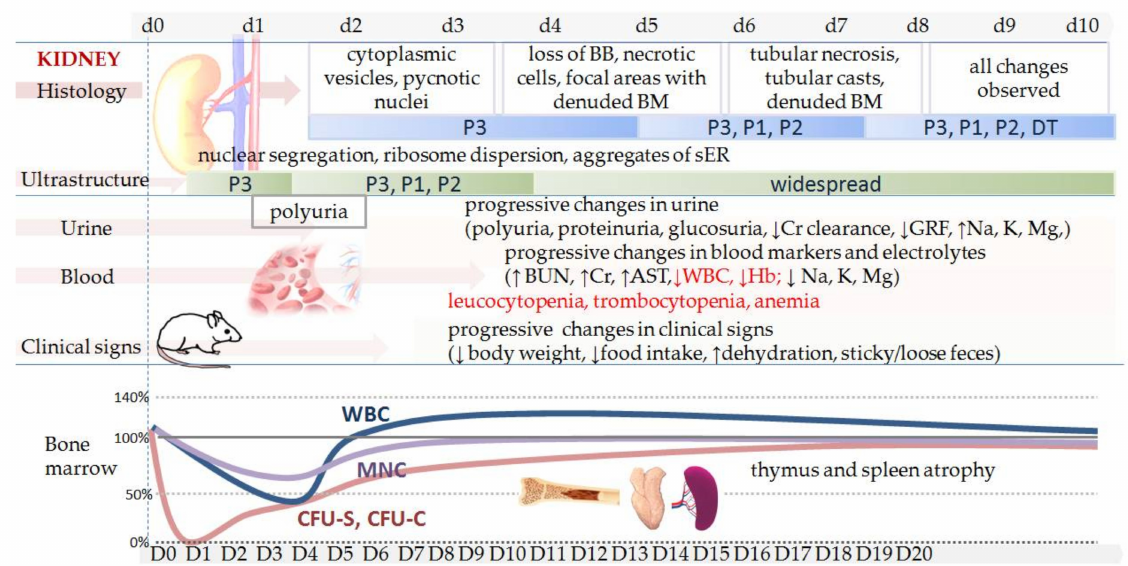
Figure 1. Schematic presentation of clinical signs and kidney function in mice after a nephrotoxic dose of cisplatin. First, two days after a single high dose of cisplatin (10–13 mg/kg; ip), minimal structural changes in the proximal tubules (P3) can be detected (i.e., mitochondria alterations, focal loss of the microvillus brush border, pycnotic nuclei, increased cytoplasmic vesicles) [63,64]. More obvious changes such as loss of the brush border or necrotic cells sloughing into the tubular lumen are usually seen 3–4 days after injection and changes are located in all parts of the proximal tubules (P1–3) [63–65]. Depending on the dose, increased BUN/Cr are usually observed 3–7 days after cisplatin injection